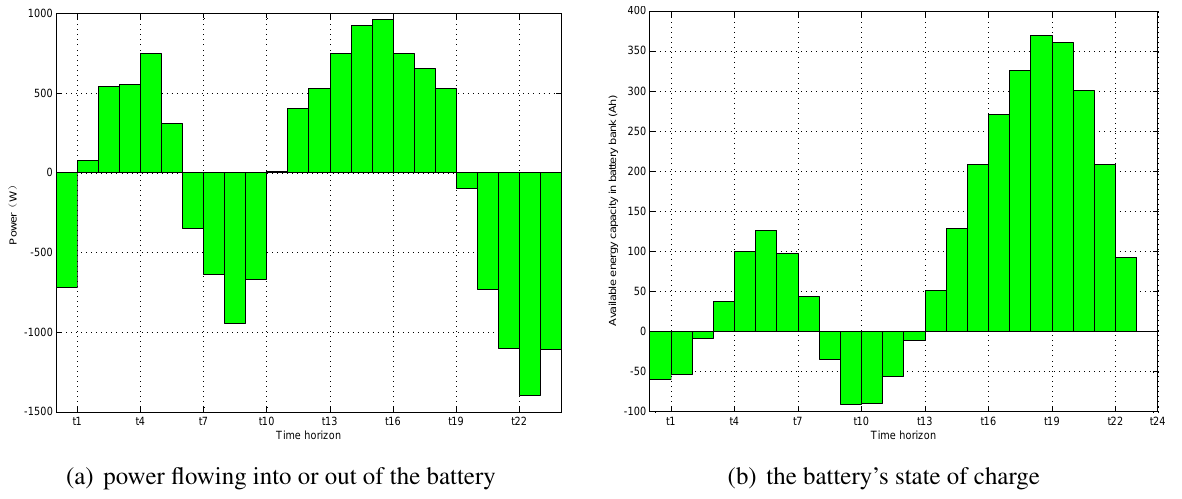
Figure 1. The battery SOC and power flowing every hour of a typical